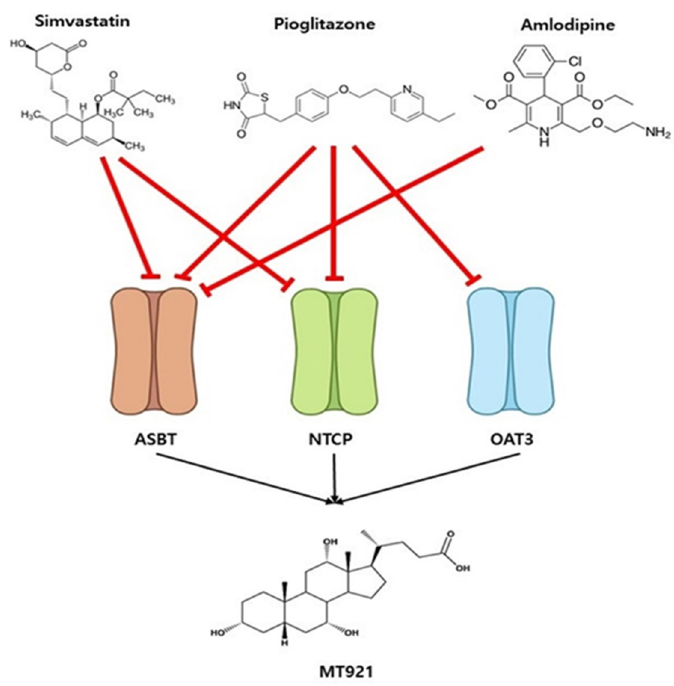
Figure 4. Drug–drug interaction networks. Simvastatin, amlodipine, and pioglitazone are the perpetrator drug in the DDI prediction model. MT921 (Cholic acid) is the victim drug. Simvastatin inhibits ASBT and NTCP. Amlodipine inhibits ASBT. Pioglitazone inhibits ASBT, NTCP, and OAT3. The red solid line represents inhibition, and the black solid line represents transport.